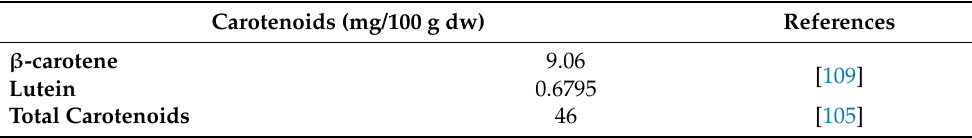
Table 4. Carotenoids, phenolic and other bioactive compounds of Brassica oleracea L. var. italica